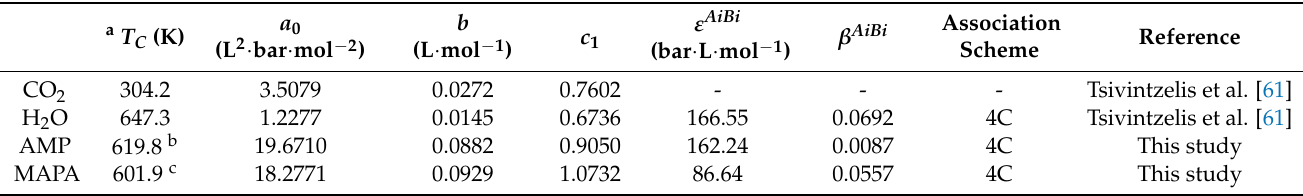
Table 8. Pure fluid parameters used in this study.